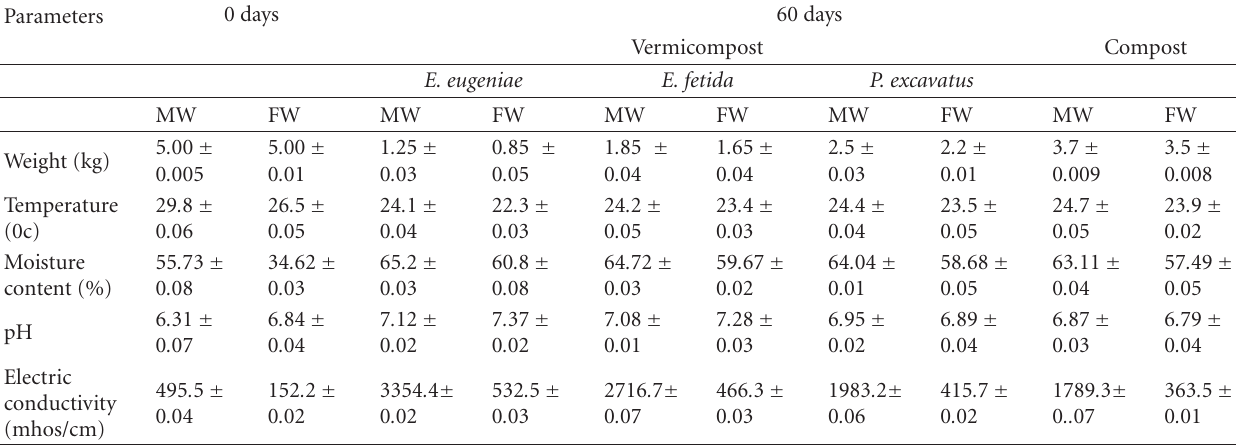
Table 2: Weight and other di ff erent physical parameters of the substrates—MW and FW—and their respective compost and vermicompost of three earthworm species (Mean ± sd; n =